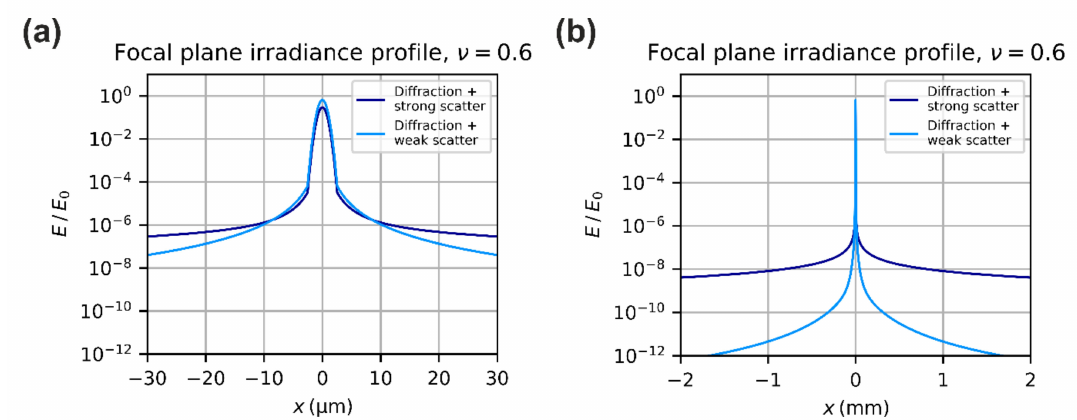
Figure 8. Approximation of the focal plane irradiance profile according to Equation (40). Calculation parameters: λ = 532 nm, f = 50 mm, F = 2.0, ν = 0.6, N ss = 12. “Strong scatter”: s = − 1, b = 1, l = 10 − 4 , “Weak scatter”: s = − 3, b = 0.01, l = 0.01. The curves are normalized using the peak irradiance E 0 of an Airy di ff raction pattern for same incident power P in . ( a ) x-coordinate ranges from − 30 µ m to + 30 µ m. ( b ) x-coordinate ranges from − 2 mm to + 2 µ